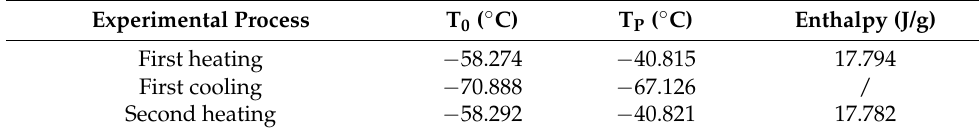
Figure 10. DSC curves of silicone rubber. Table 1. DSC experimental data and calculation results of silicone rubber.